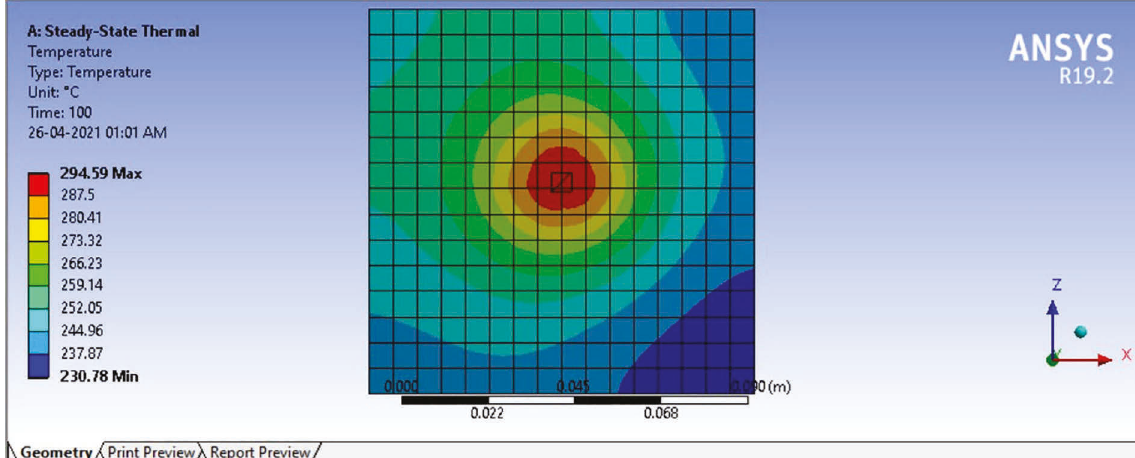
Figure 13: Temperature distribution with a hardened H13 steel tool square pin profile when tool temperature was 293 ° C.